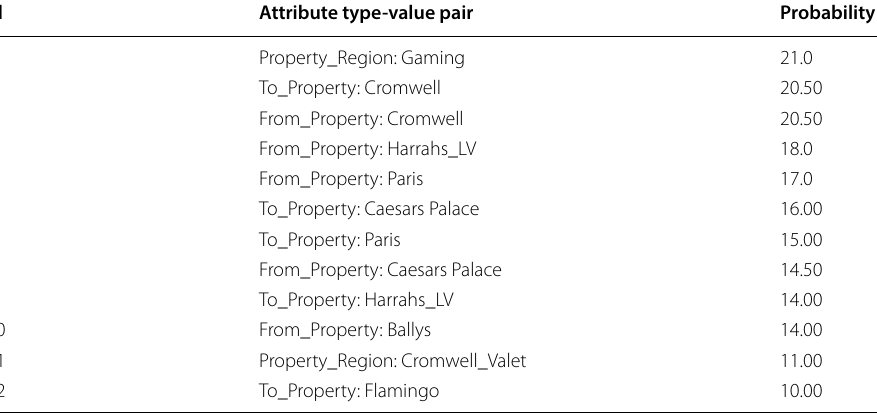
Table 11 Node-weight for Caesars-WiFi